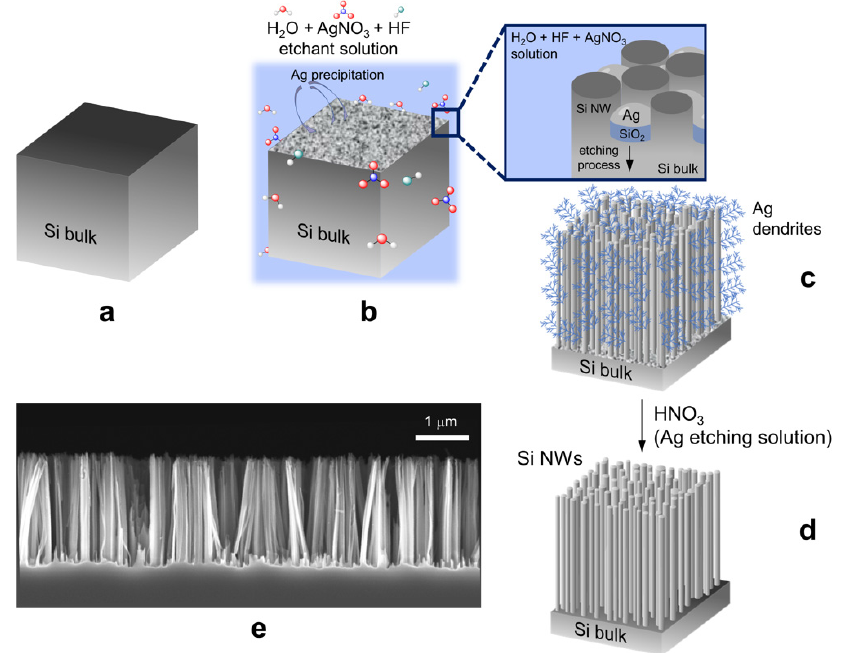
Figure 1. Scheme for the realization of vertical arrays of Si nanowires by Ag-mediated metal-assisted chemical etching. ( a ) The Si wafer was first treated for the removal of the native oxide and then ( b ) etched in an AgNO 3 /HF solution as described in the Materials and Methods section. ( c ) As shown in the inset of ( b ), during the etching ( c ) the formation of Ag dendrites occurred as a byproduct of the rection, ( d ) which were subsequentially removed by etching in an HNO 3 solution. ( e ) Cross-section scanning electron microscopy of the used 2 µm long Si NW array.